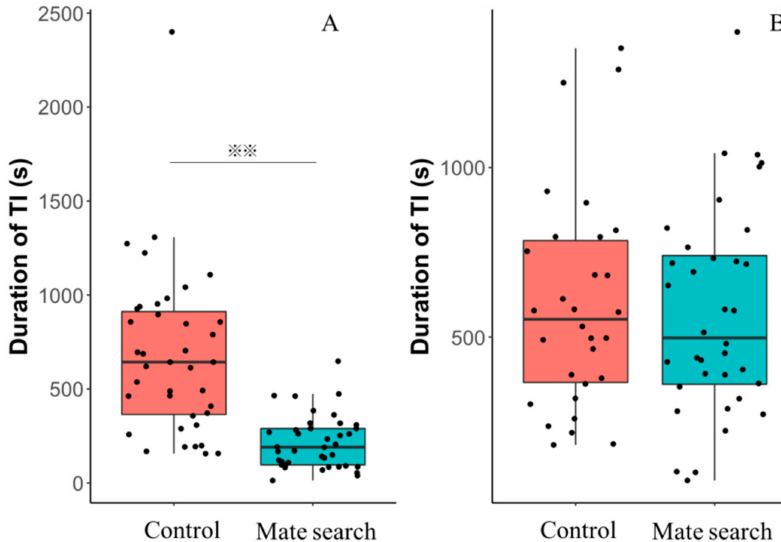
Figure 3. Comparison of the SPW from mate searching group (cyan) versus the control (orange) in duration of TI: ( A ) Duration of TI in male mate searching and control. ( B ) Duration of TI of female in mate searching and control. Box plots have a horizontal median, interquartile range box. Dots are experimental trial data points. Asterisks indicate a significant di ff erence from the control ( p <